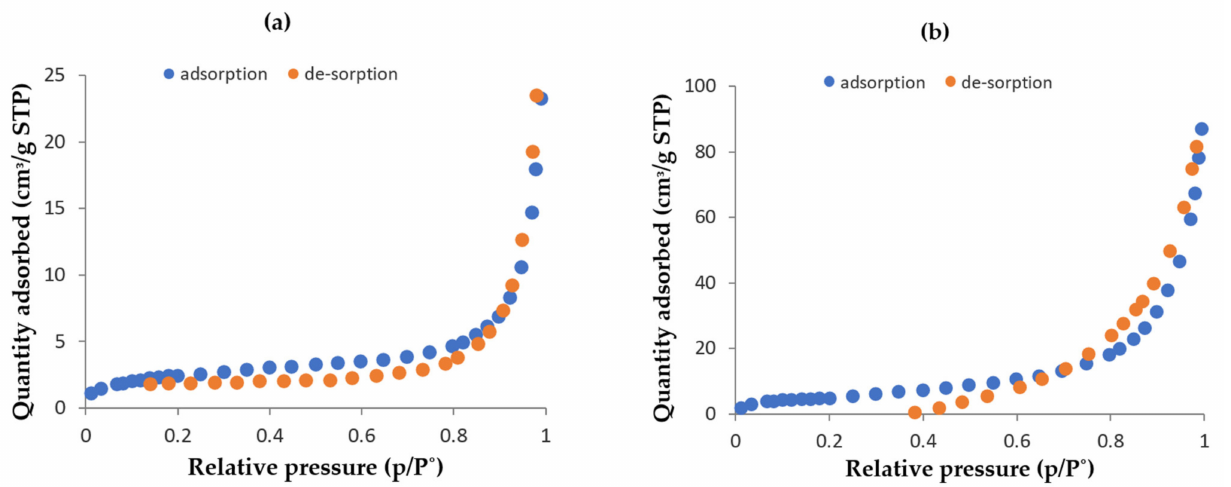
Figure 5. BET adsorption and desorption plots of ( a ) bare pPD and ( b ) Fe-pPD.